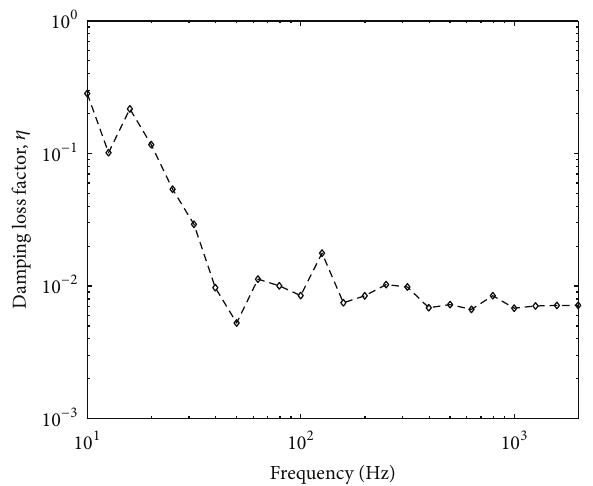
Figure 7: The damping loss factor of the high mobility reception plate.